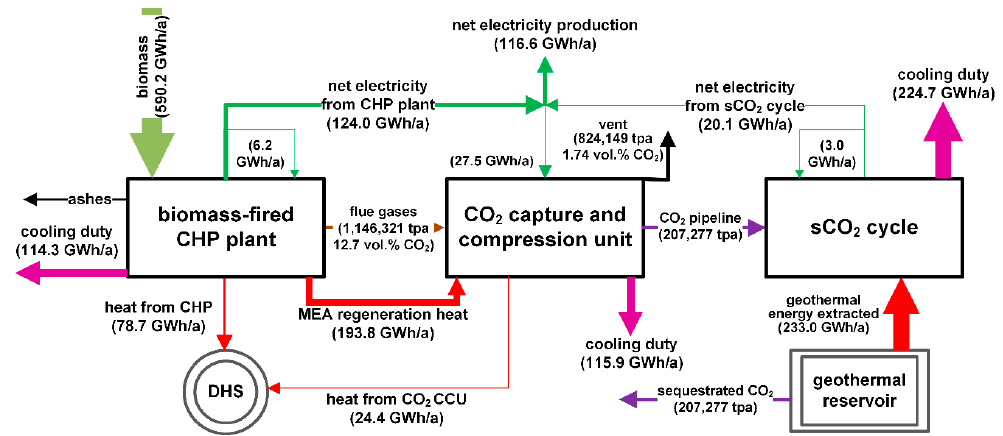
Figure 9. Simplified schematic of the analyzed system with the main components of the mass and energy balance.